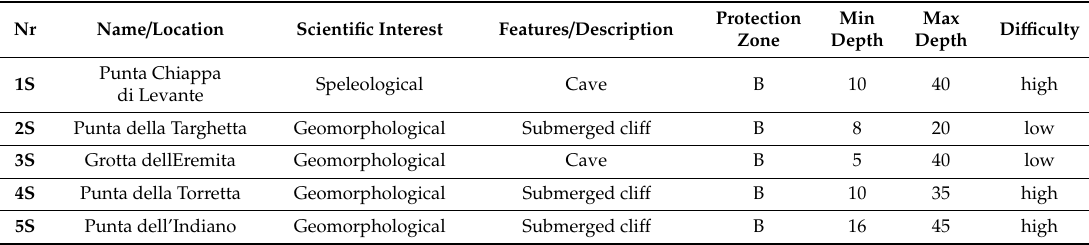
Table 2. Marine geosites (minimum and maximum depth are expressed in meters). The eighth column refers to the qualitative level of di ffi culty to reach a certain submerged geosite through scuba diving (source: